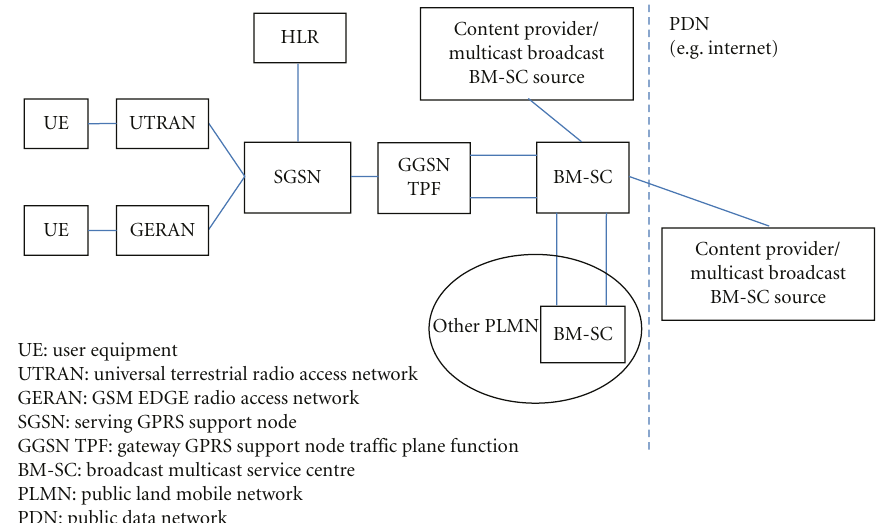
Figure 5: The UMTS MBMS